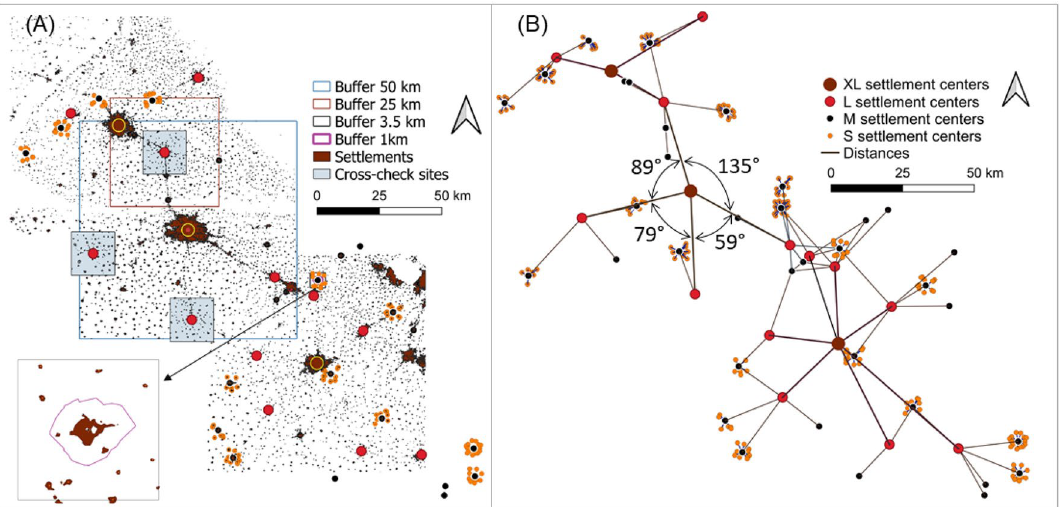
Figure 5. Three levels distance and angle assessments in the N-Indian Punjab. ( A ) Map with buffer sizes: 50 km, 25 km, and 3.5 km around XL, L, and M settlements; insert: buffer of 3.5 km with 1 km inner threshold around M settlements. ( B ) Hierarchy network: level 1 measurements from XL to L settlements, level 2 measurements from L to M settlements, and level 3 measurements from M to S settlements. Exemplary angle measurements are shown for one XL settlement (Settlement binary map of 2016).